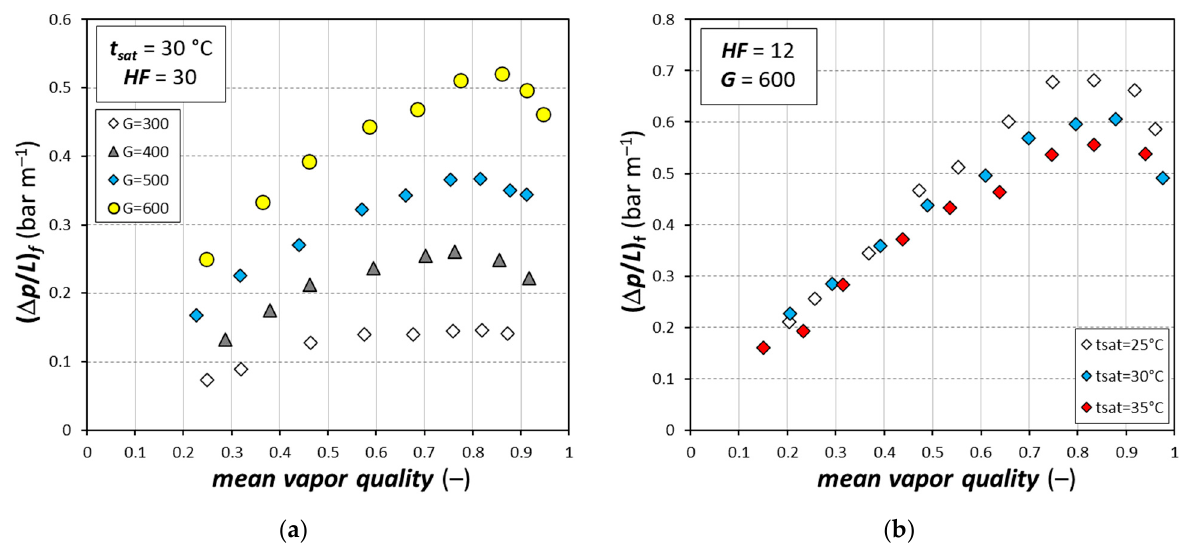
Figure 6. Frictional pressure gradient versus mean vapor quality. ( a ) Data at t sat = 30 °C and HF = 30 kW m − 2 at different mass velocity; ( b ) data at HF = 12 kW m − 2 and G = 600 kg m − 2 s − 1 at different saturation temperature.